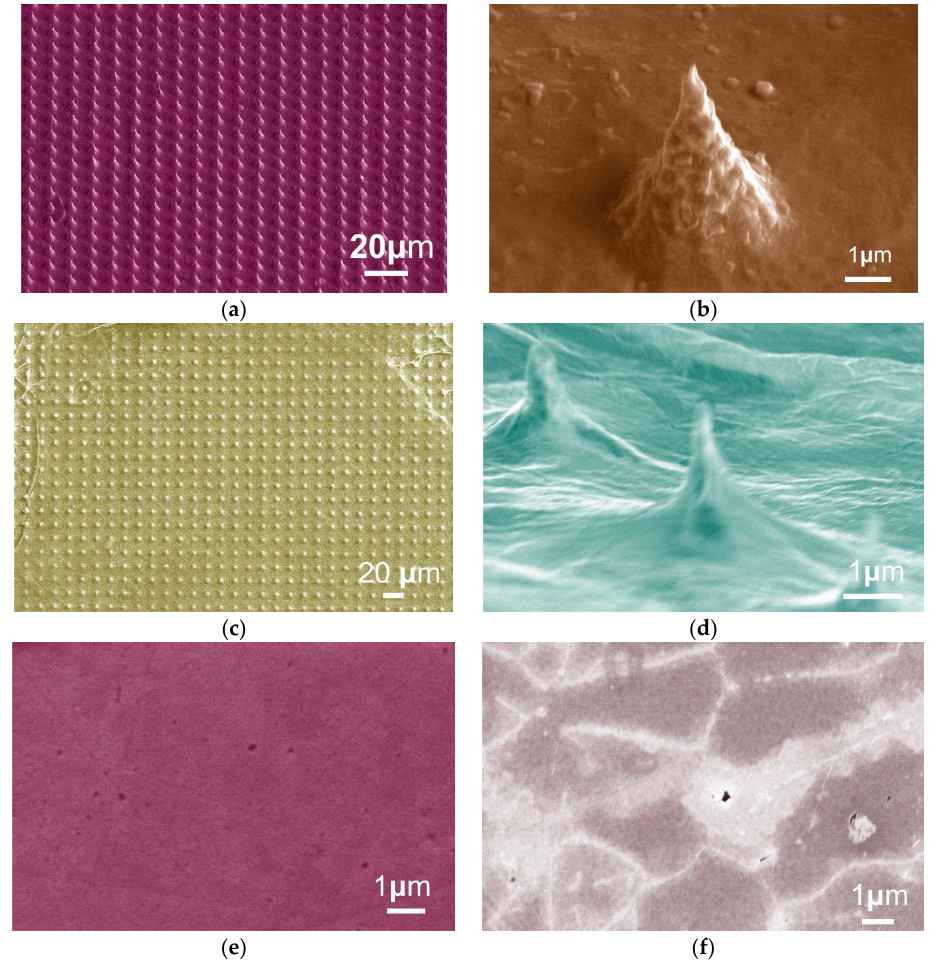
Figure 6. SEM graph of ( a ) Mo tip array; ( b ) perspective view of single Mo tip; ( c ) Mo tip array with grapheme; ( d ) perspective view; ( e ) bulk Mo; and ( f ) bulk Mo with graphene. grapheme; ( d ) perspective view; ( e ) bulk Mo; and ( f ) bulk Mo with